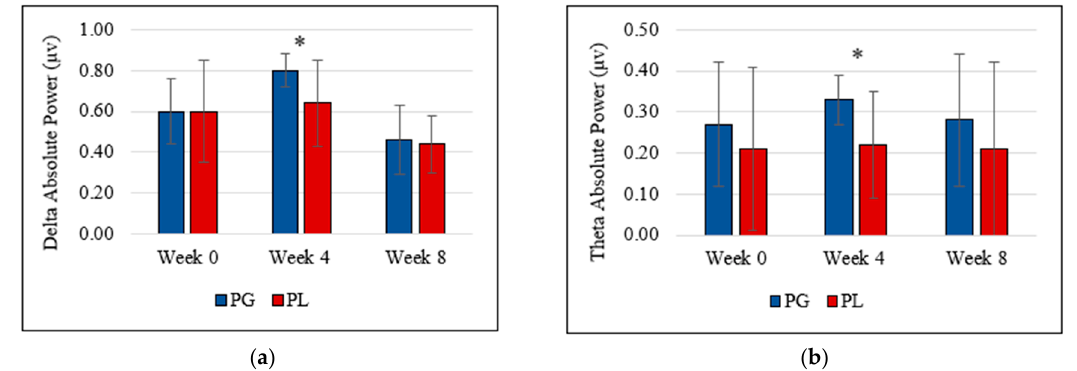
Figure 1. ( a ) Delta absolute power and ( b ) theta absolute power deviation during the intervention. (PG = Probiotic Group, PL = Placebo Group).